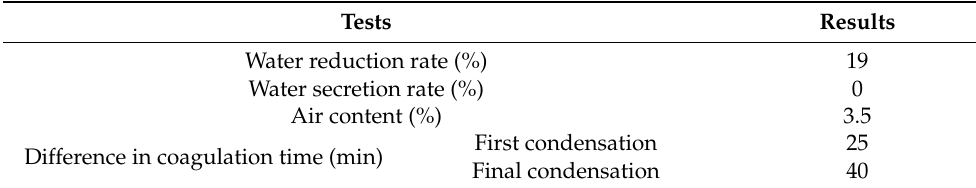
Figure 1. Testing of flow diameter. Table 3. Technical performance of naphthalene ZH-3 air-entraining superplasticizer.